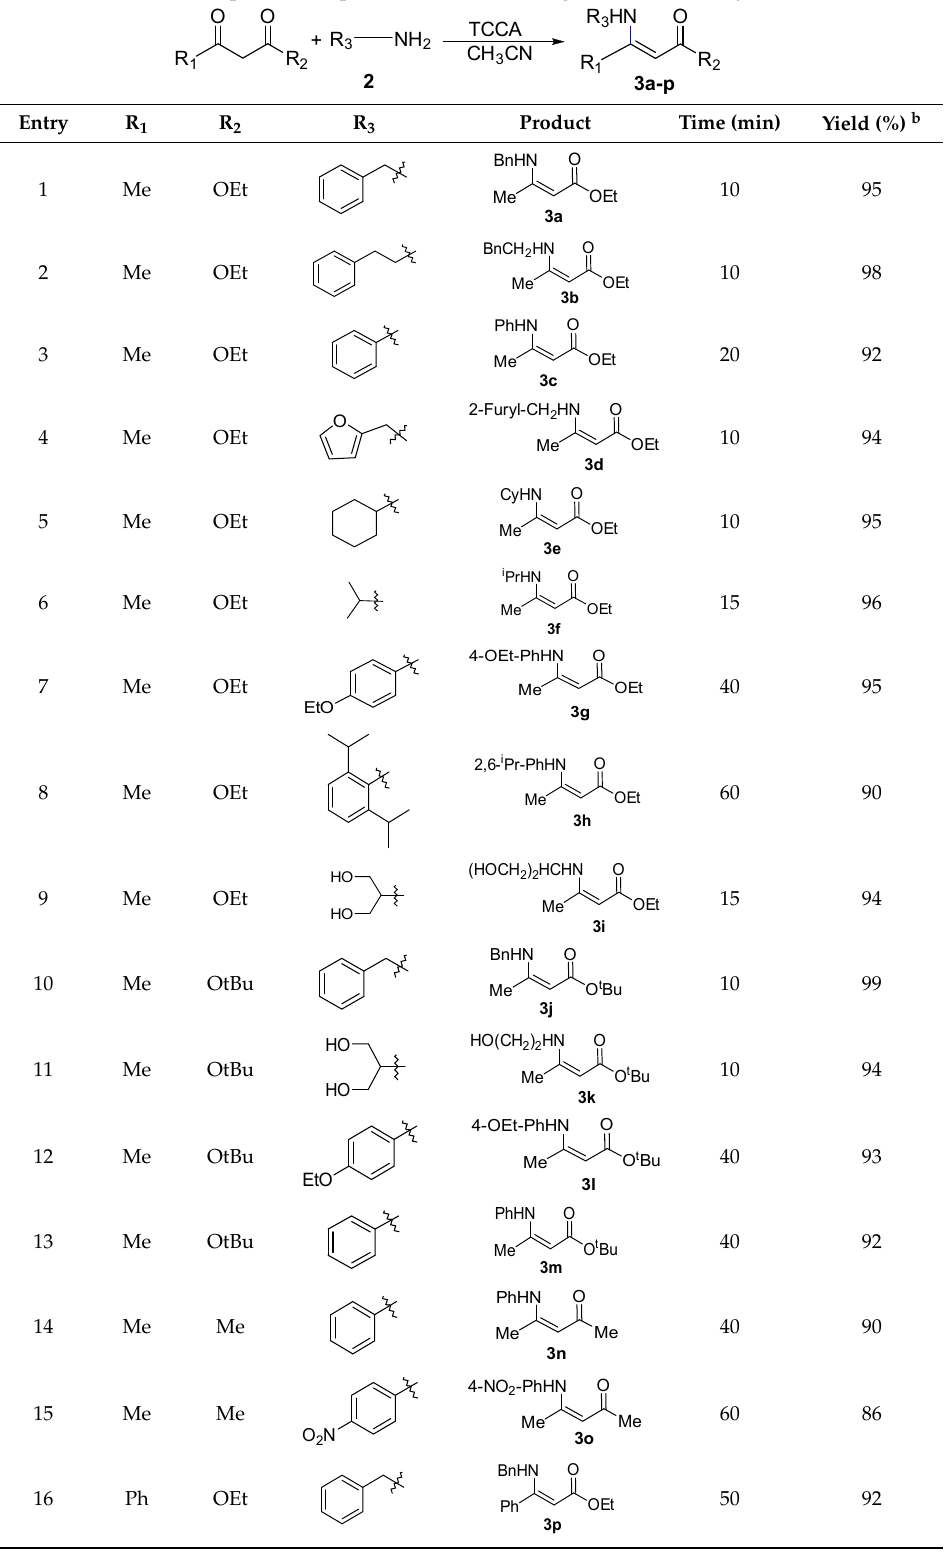
Table 2. Scope with respect to substrates using TCCA as a catalyst a.